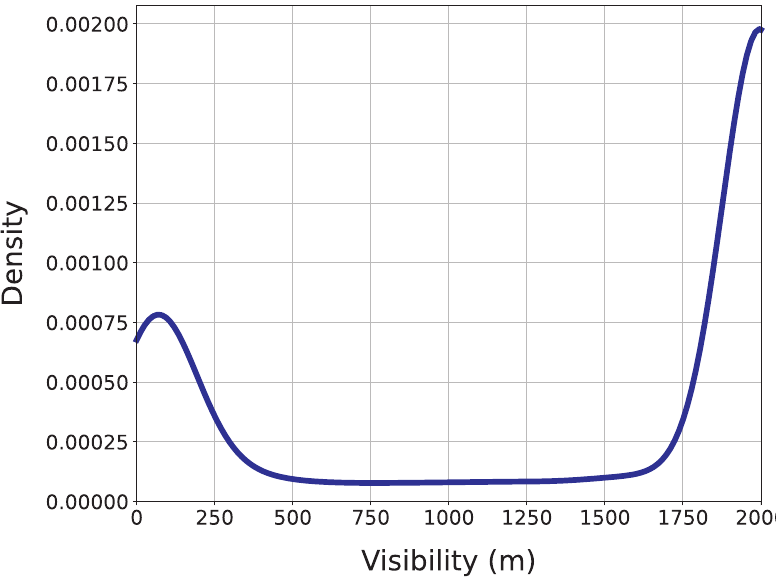
Figure 6. Density function of the visibility time series